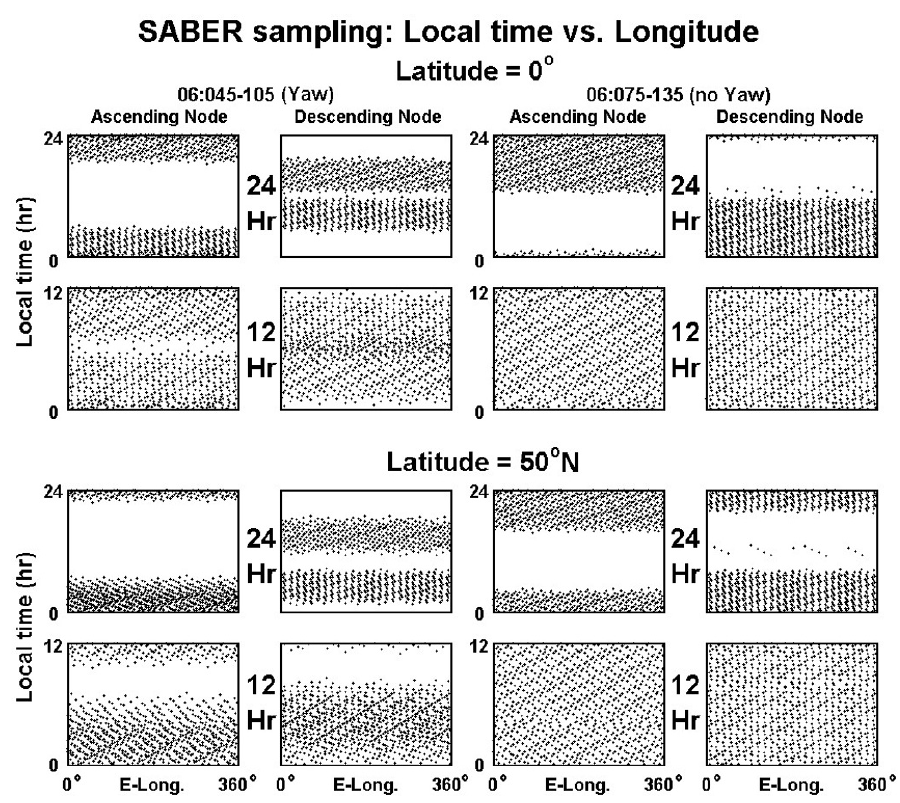
Fig. 6. SABER sampling: Local time vs. Longitude for ascending and decending nodes, migrating diurnal (24h) and semi-diurnal (12h) tides, without and with Yaw maneuver, 0 and 50 degree Latitudes, to show effect of removing ascending and descending node 60d longitude means. The “no YAW” interval shown is for SABER looking southward, i.e. a worst case for 50 ◦